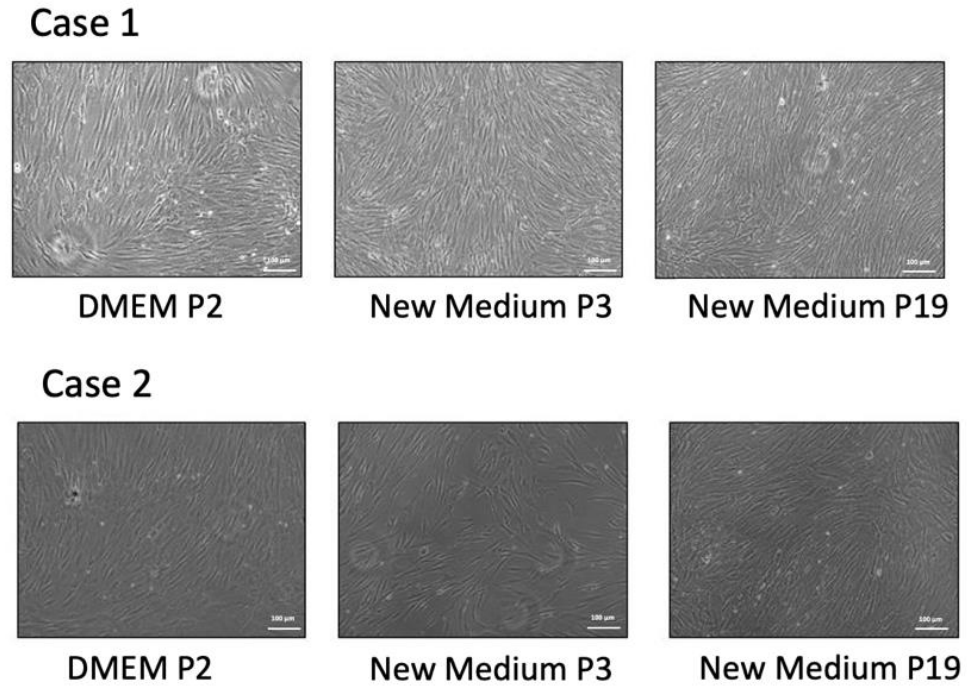
Figure 1. The cell morphology of HBMSC cultured in traditional medium (DMEM) and new formula medium (BK medium). The morphology of the cells cultured in the traditional media was similar to that cultured in the new formula medium.